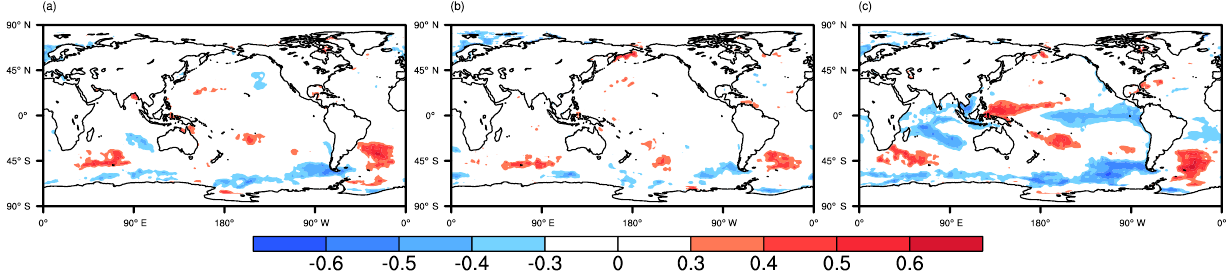
Figure 4. Correlation coefficients (unitless) of the monthly haze days of (a) JJJ, (b) JZH, and (c) GG with SST in winter, after applying band-pass filtering of 2–8 years to both the data of haze days and SST. Shade denotes that results pass 95% significance